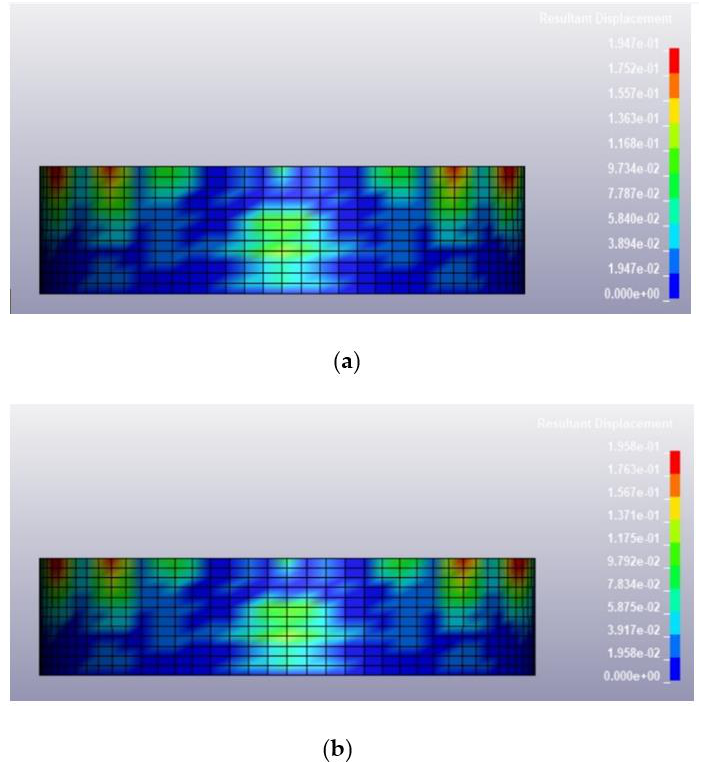
Figure 10. Deformed shape of the tank under blast intensity of 1500 kg TNT equivalent mass 25 m away, ( a ) 100% fill level and ( b ) 0% fill level.